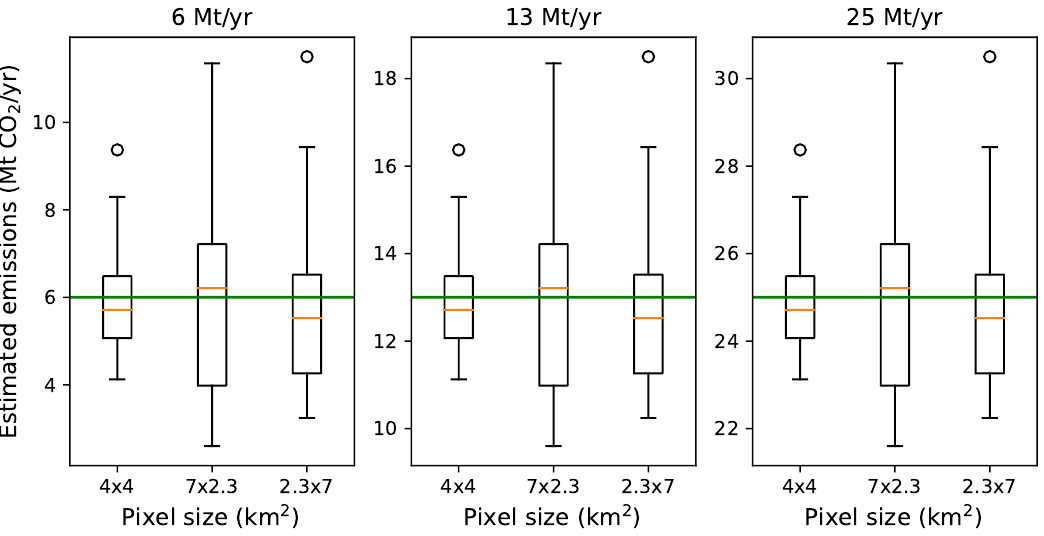
Figure 9. Emission estimates from an ensemble of 30 simulations for square pixels (4 × 4 km 2 ), and rectangular pixels with the long side oriented both perpendicular to (7 × 2.3 km 2 ) and along (2.3 × 7 km 2 ) the wind, as in Figure